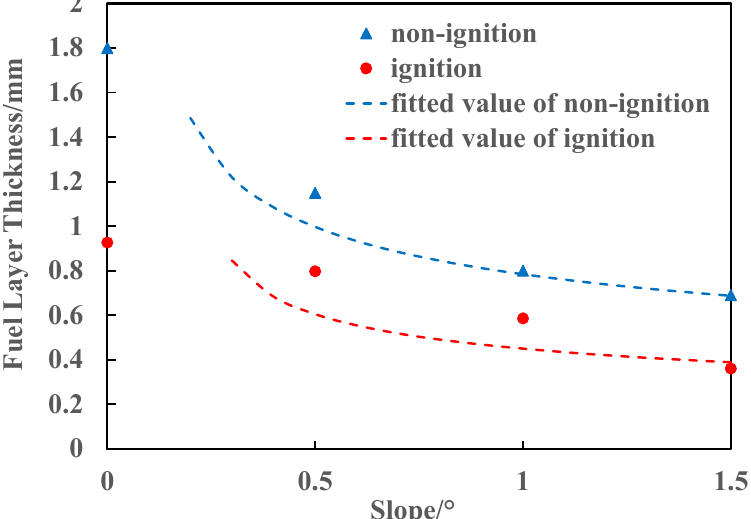
Figure 13. Variation of the oil layer thickness and fitted value with slope.